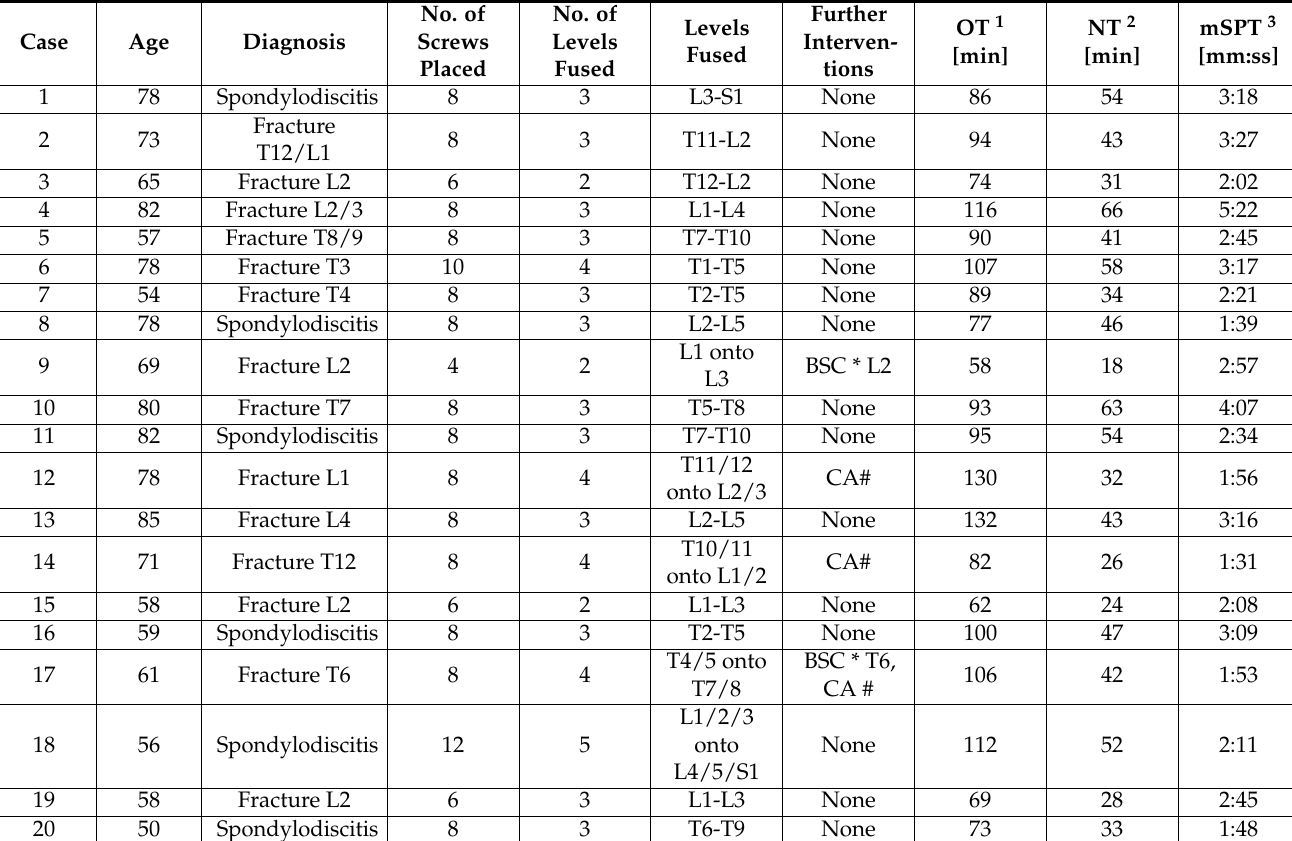
Table 1. General patient data and procedure characteristics.